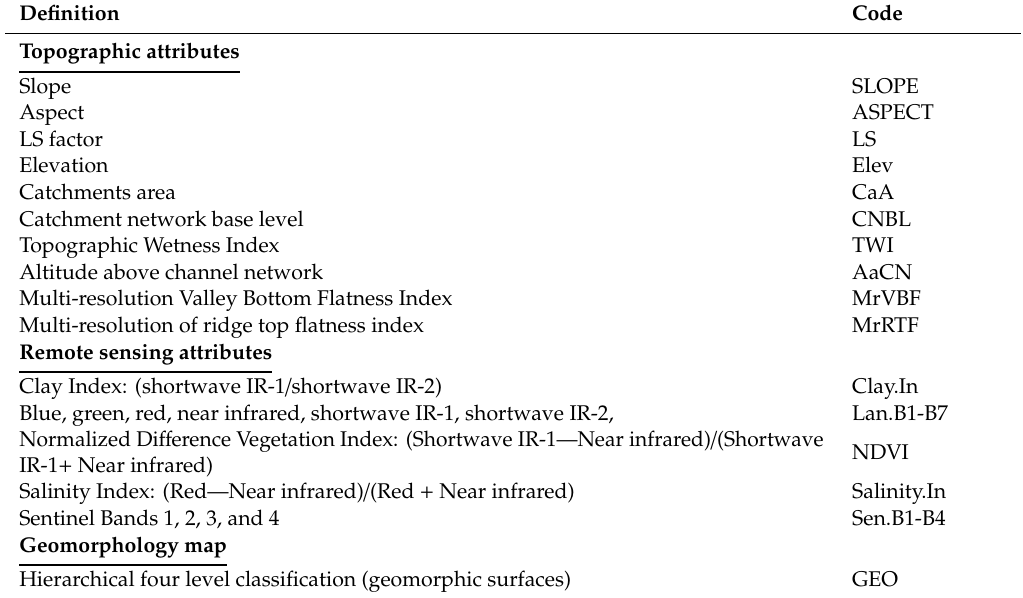
Table 2. Environmental variables used as soil formation factors in the study